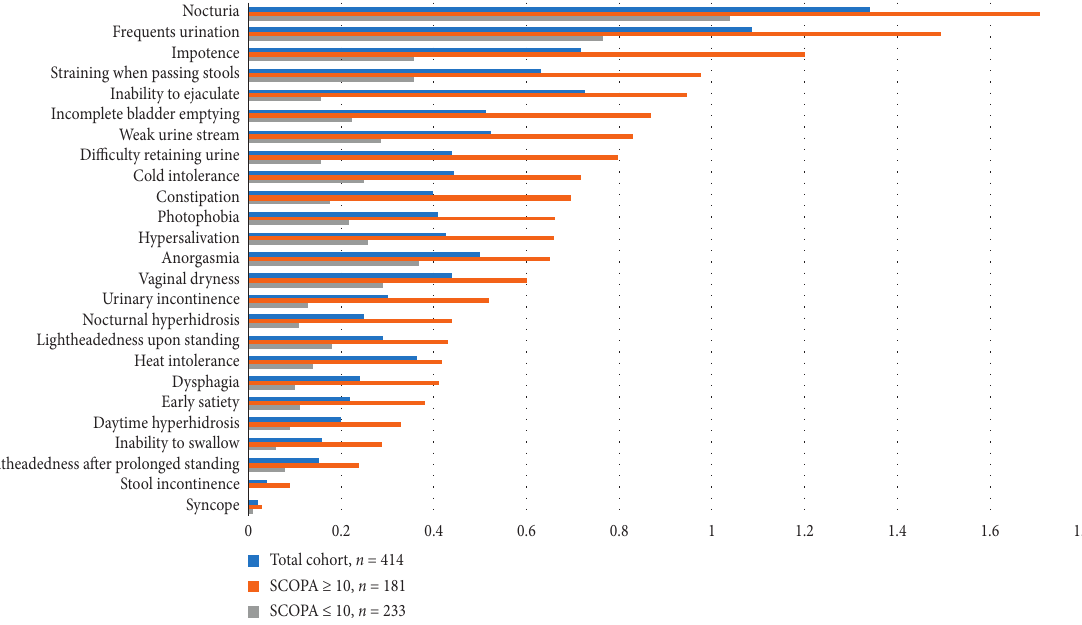
Figure 2: Frequency of reported SCOPA-AUT items in our PD cohort. SCOPA-AUT: Scales for Outcomes in Parkinson’s Disease- Autonomic dysfunction; PD: Parkinson’s